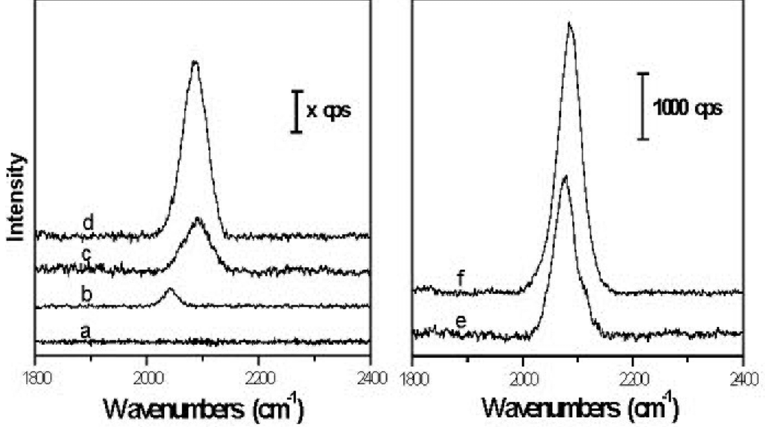
Figure 5. SERS spectrum of (a) blank on ITO glass slice assembled with spherical gold nanoparticles, Raman spectrum of (b) 10 M SCN - solution, and SERS spectra of SCN - on ITO glass slices assembled with (c) spheres, (d) hexagons, (e) tadpoles, and (f) boots. Integration times are (a) 60 s, (b) 800 s (scale bar: 0.25 cps), (c) 20 s (scale bar: 10 cps), (d) 20 s (scale bar: 10 cps), (e) 1 s (scale bar: 1000 cps), and (f) 1 s (scale bar: 1000